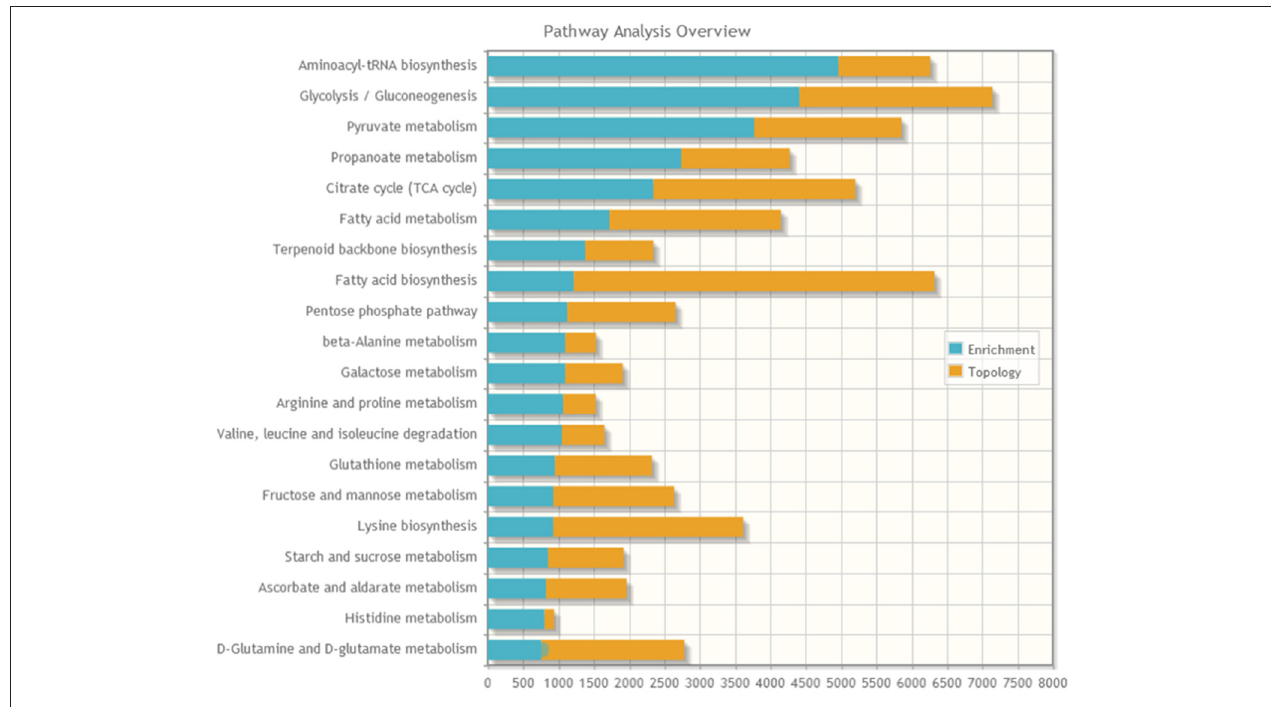
FIGURE 5 | The stacked bars below show a summary of the protein–metabolite joint evidence from enrichment analysis and topology